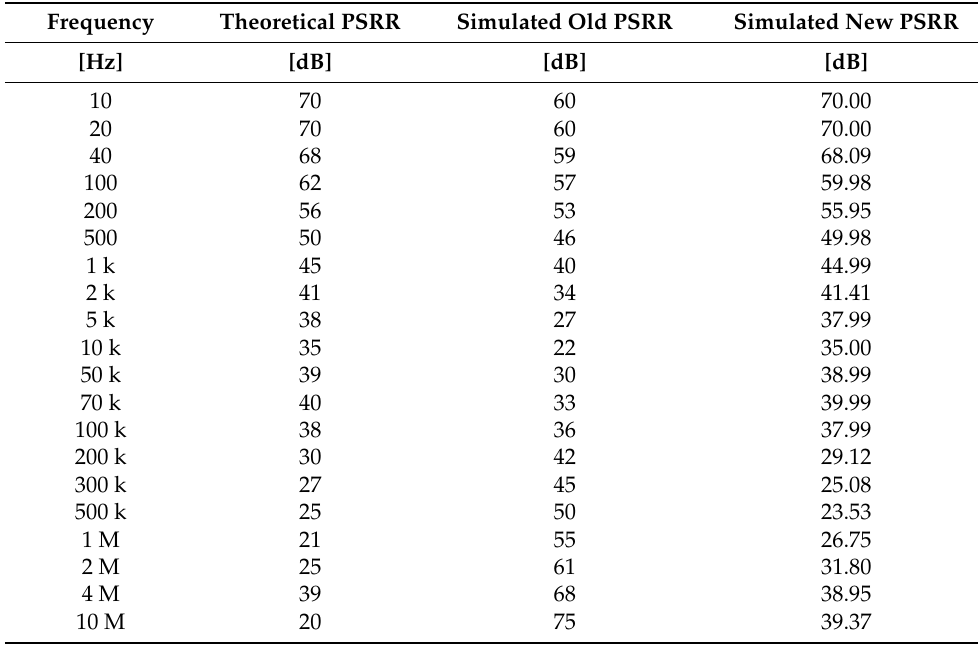
Table 2. Theoretical PSRR vs. Simulated Old PSRR vs. Simulated New PSRR for a load capacitor of 1 µ F.